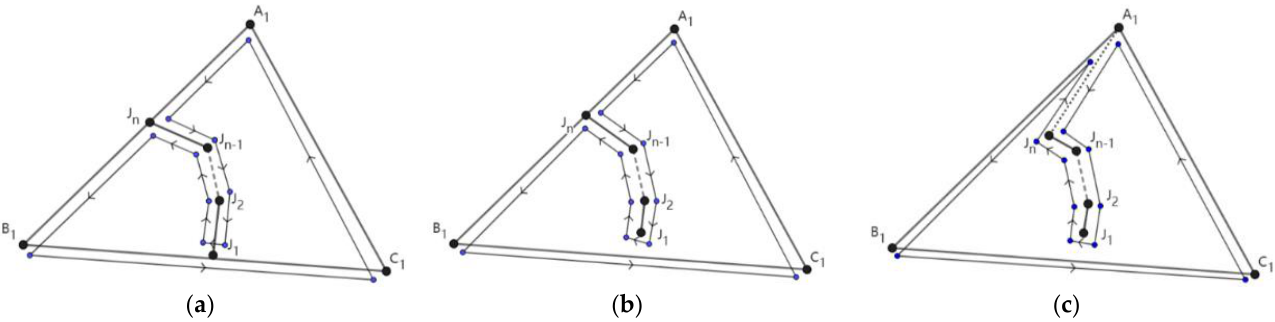
Figure 9. Schematic diagram of three kinds of triangle closed polygon. ( a ) has two points at the edge. ( b ) has one point at the edge. ( c ) has all points inside the triangle.